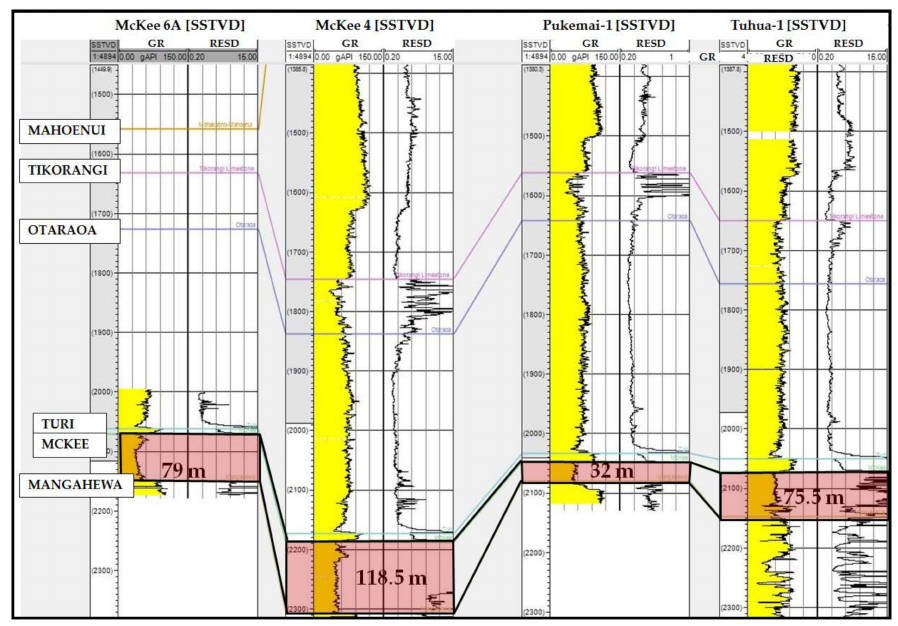
Figure 3. Well correlation of four selected wells that encounter the McKee Formation in the McKee field. GR: Gamma Ray; RESD: Deep Resistivity; SSTVD: SubSea True Vertical Thickness.